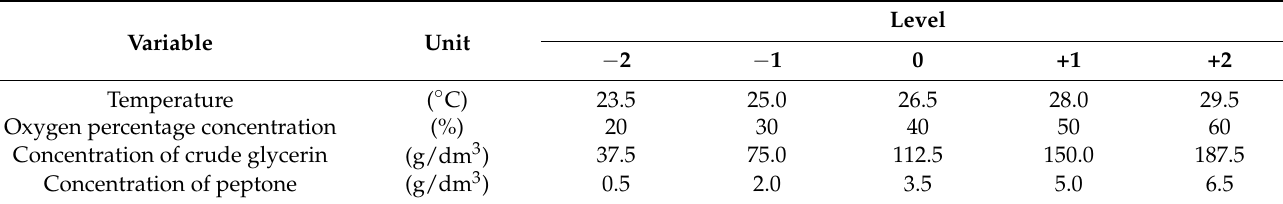
Table 5. The Plackett–Burman design of the